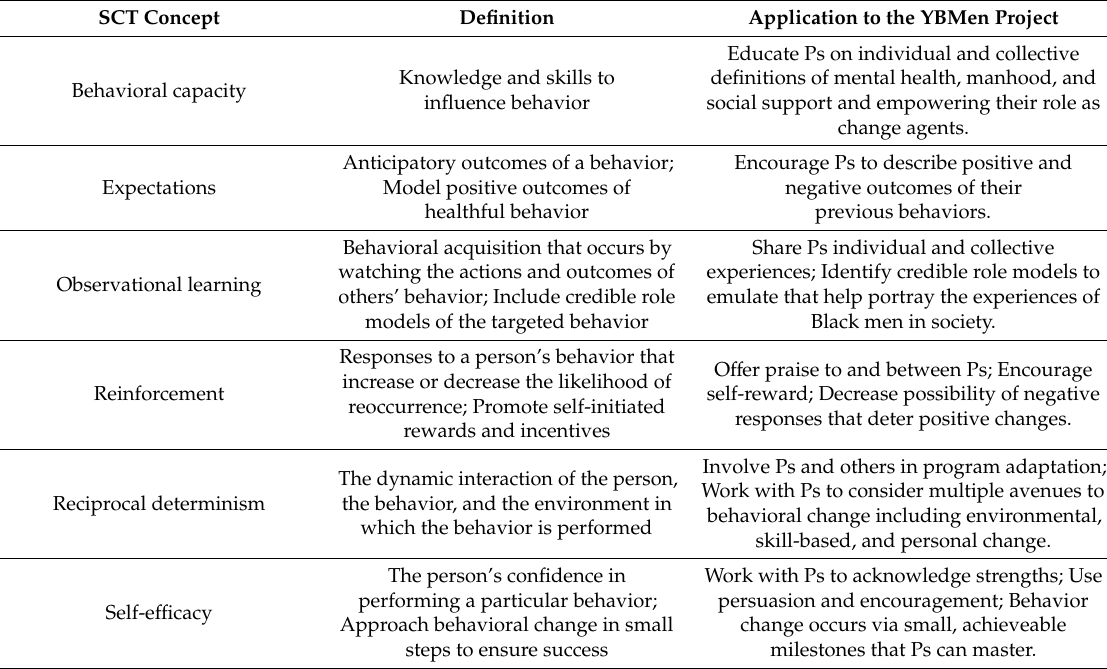
Table 1. Social cognitive theory (SCT) and how it is operationalized in the Young, Black Men, Masculinities, and Mental Health (YBMen)